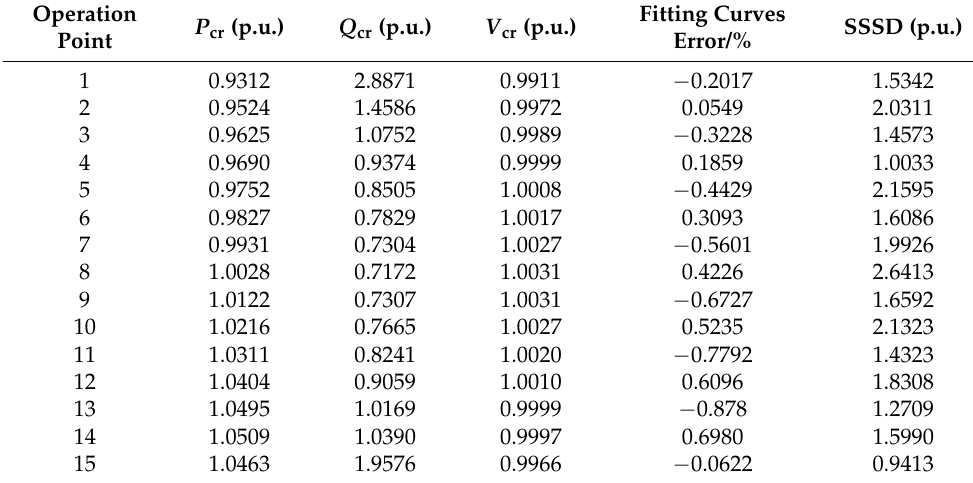
Table 1. Time domain simulation SSSR parameters of synchronous unit G 89.